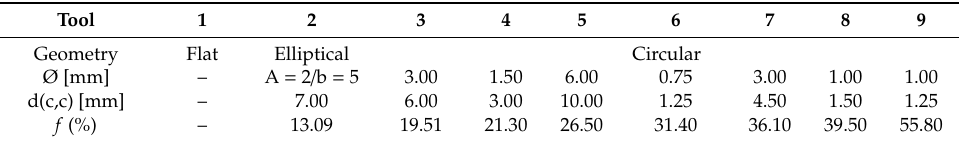
Table 1. Surfaces parameters of the manufactured tools.